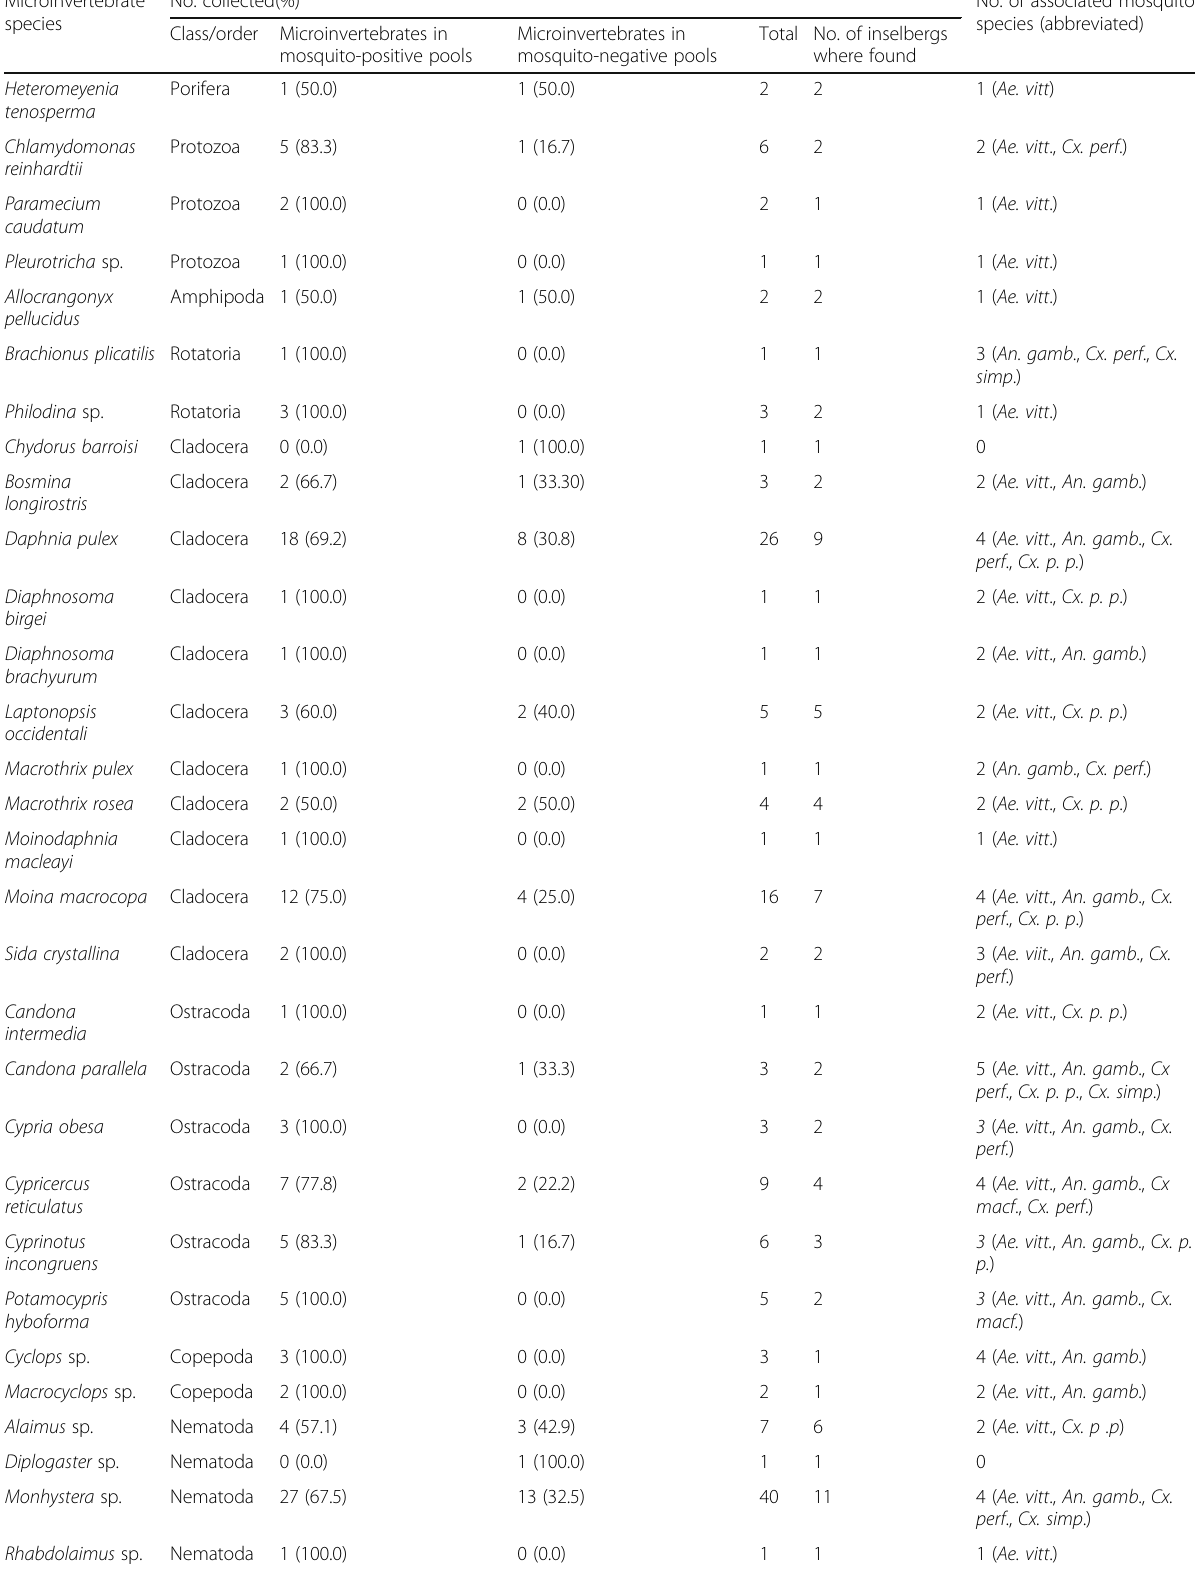
Table 2 Microinvertebrates coinhabiting mosquito habitats in rock pools on inselbergs within Kaduna State, Nigeria Microinvertebrate No. species